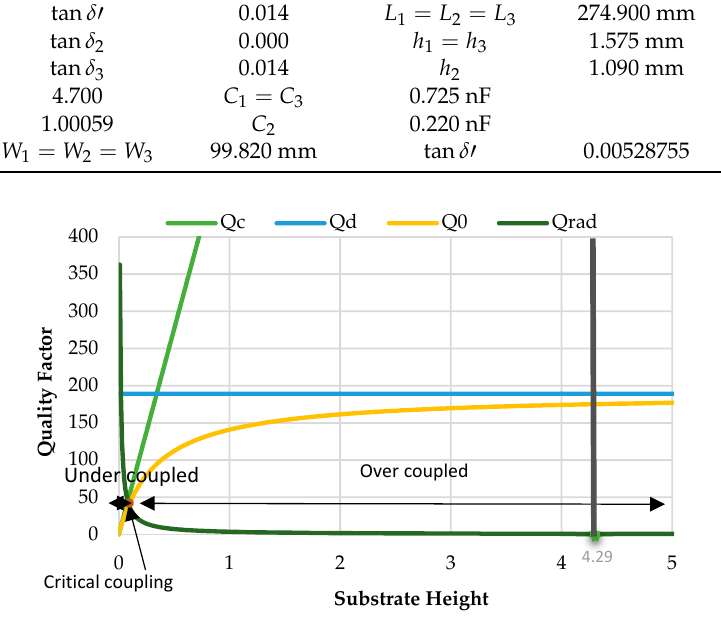
Figure 11. Quality factor as a function of substrate height.